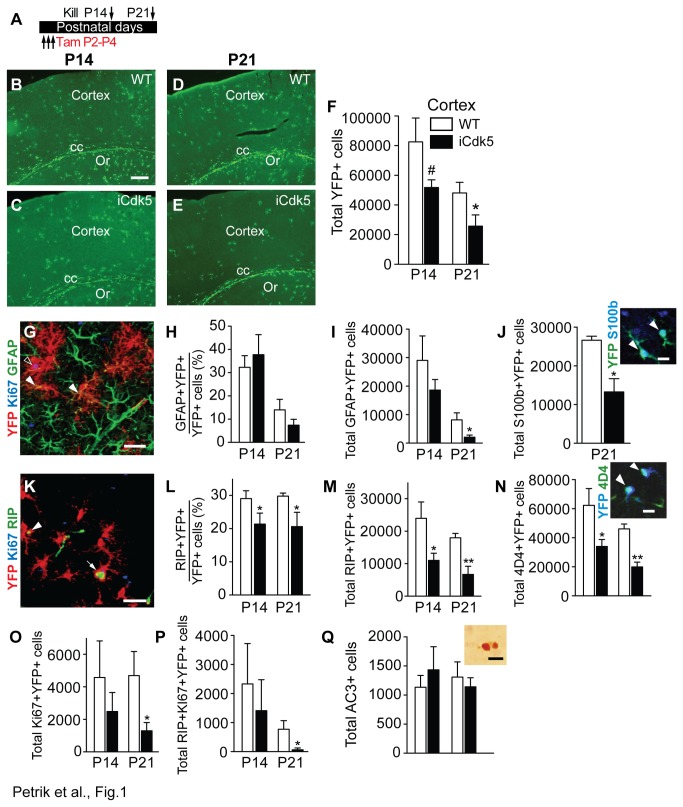
Inducible deletion of Cdk5 in nestin-lineage cells (Tam P2-P4) results in fewer YFP+ glial cells in cortex.(A) Paradigm of Tam administration. Representative images for brain sections stained for YFP at P14 (B, C) and at P21 (D, E) show YFP+ cells in the cortex, corpus callosum (cc), and stratum oriens (Or) of the hippocampus in the WT (top) and iCdk5 littermates (bottom; scale bar, s.b.=100 µm). (F) Stereological quantification of YFP+ cells in the cortex. (G) Representative microphotograph of cortex shows YFP+ cells (red) overlapping with GFAP (green; closed arrowheads) or with GFAP and Ki67 (blue; open arrowhead; s.b.=20 µm). (H) Percent of YFP+ cortical cells expressing both GFAP and YFP. (I) Total number of GFAP+YFP+ cortical cells. (J) Total number of S100b+YFP+ cortical cells at P21. Inset shows double-positive cells (arrowheads; s.b.=10 µm). (K) Representative image of cortex shows YFP+ cells (red) overlapping with RIP alone (green; arrowhead), or with RIP and Ki67 (arrow; s.b.=20 µm). (L) Percent of YFP+ cortical cells expressing both RIP and YFP. (M) Total number of RIP+YFP+ cortical cells. (N) Total number of 4D4+YFP+ cortical cells at P21. Inset shows double-positive cells (arrowheads; s.b.=10 µm). (O) Total number of Ki67+YFP+ cortical cells. (P) Total number of RIP+Ki67+YFP+ cortical cells. (Q) Total number of AC3+ cortical cells (inset shows two AC3+ cells; s.b.=10 µm).